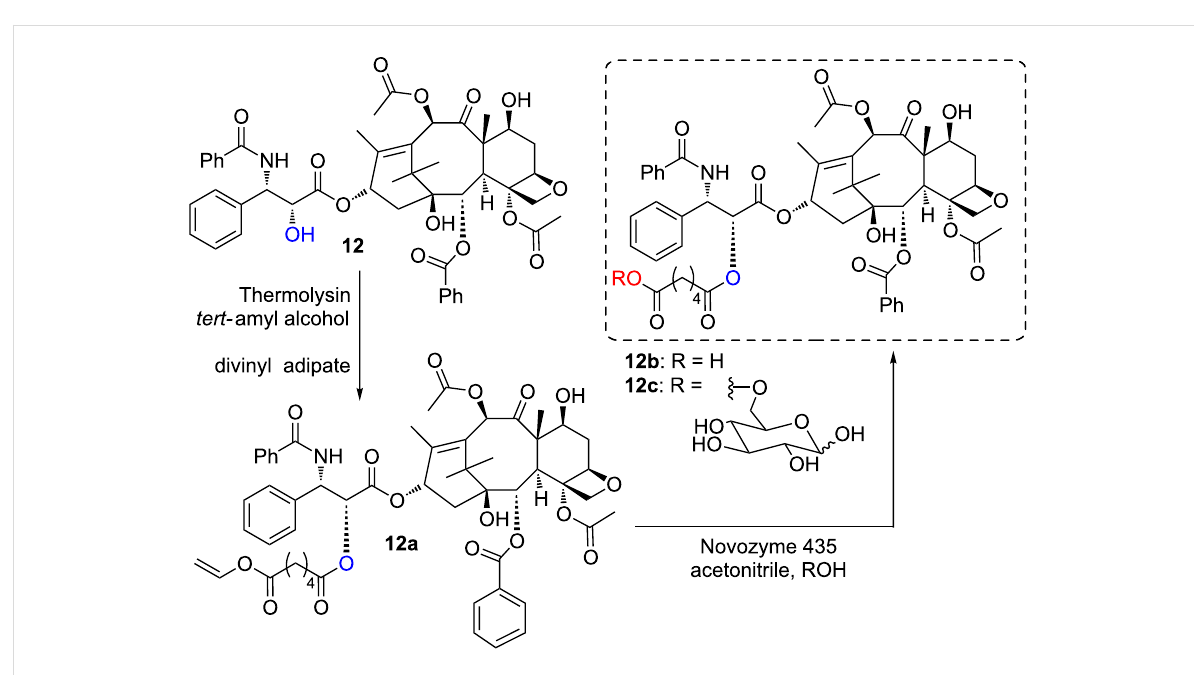
Scheme 2: Biocatalyzed synthesis of paclitaxel derivatives.